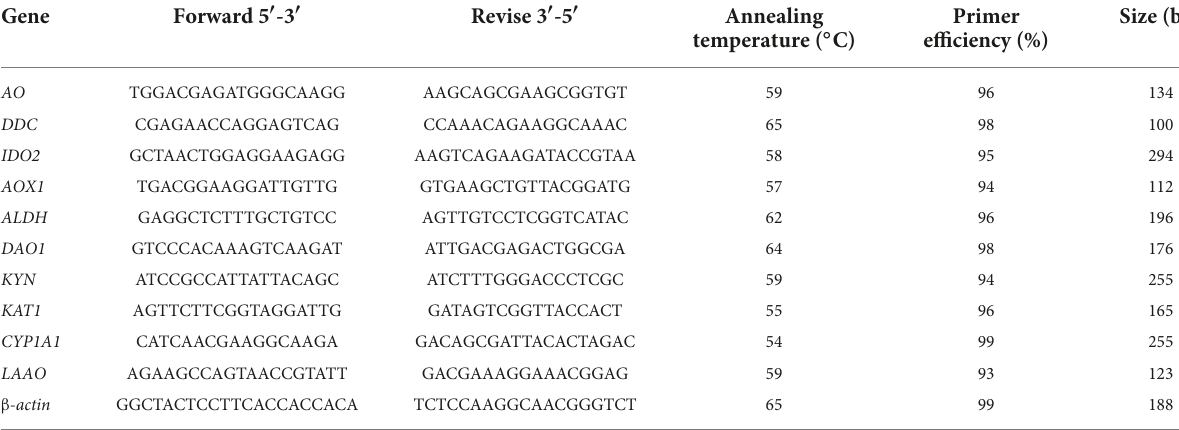
TABLE 3 PCR primers for gut tryptophan metabolism pathway-related genes of grouper. Gene Forward 5 (cid:48) -3 (cid:48)